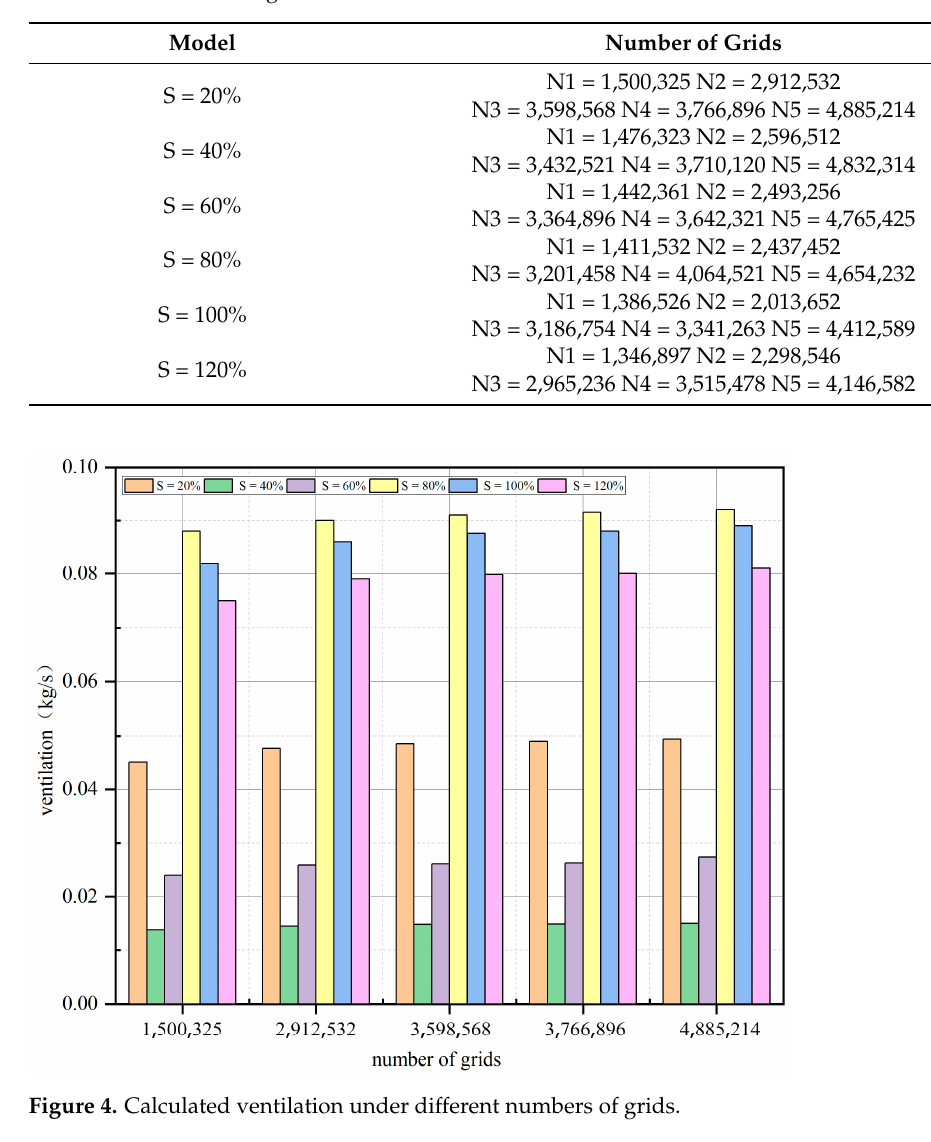
Figure 5. The computational error of adjacent grids. N1N2